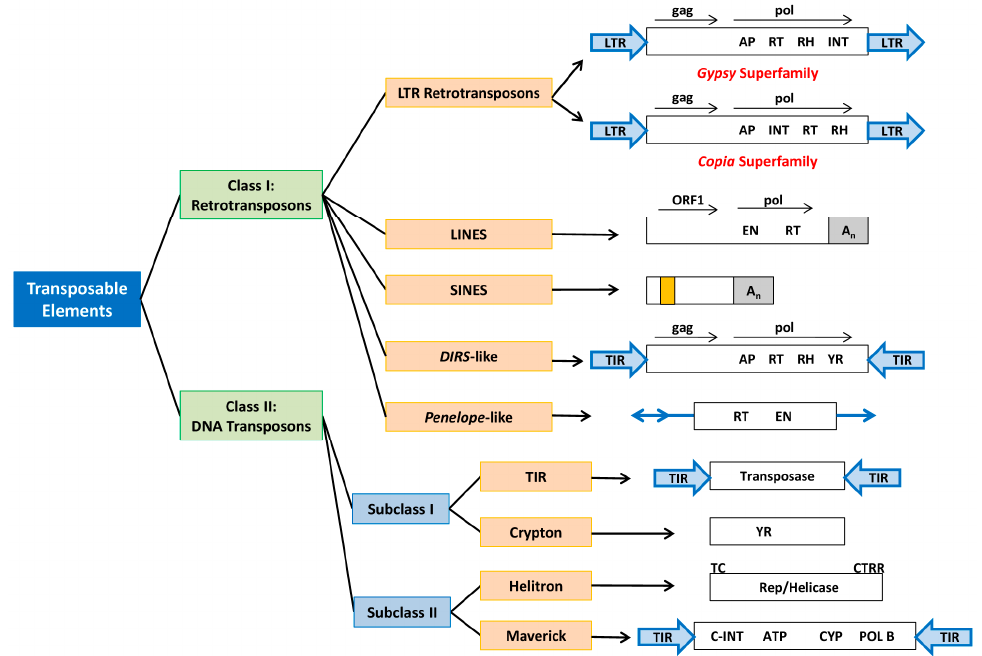
Figure 1. The orders and superfamilies of transposable elements present in fungi. (Note: LTR = long terminal repeats, TIR = terminal inverted repeats, AP = aspartic protease, RT = reverse transcriptase, RH = RNase H, INT = integrase, EN = endonuclease, An = poly(A) tail, YR = tyrosine recombinase, ATP = packaging ATPase, CYP = cysteine protease, POL B = DNA polymerase B. Internal RNA polymerase III promoter region of SINEs is indicated by orange box.) (Source: Credit Ilakiya